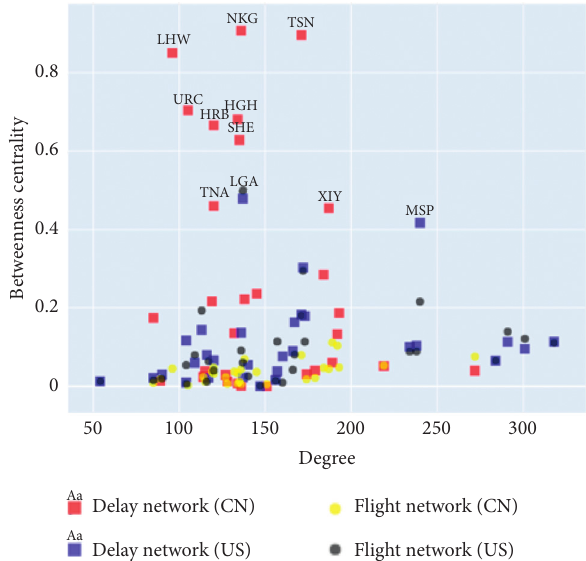
Figure 3: Comparisons on the betweenness centrality of networks of USA and China.